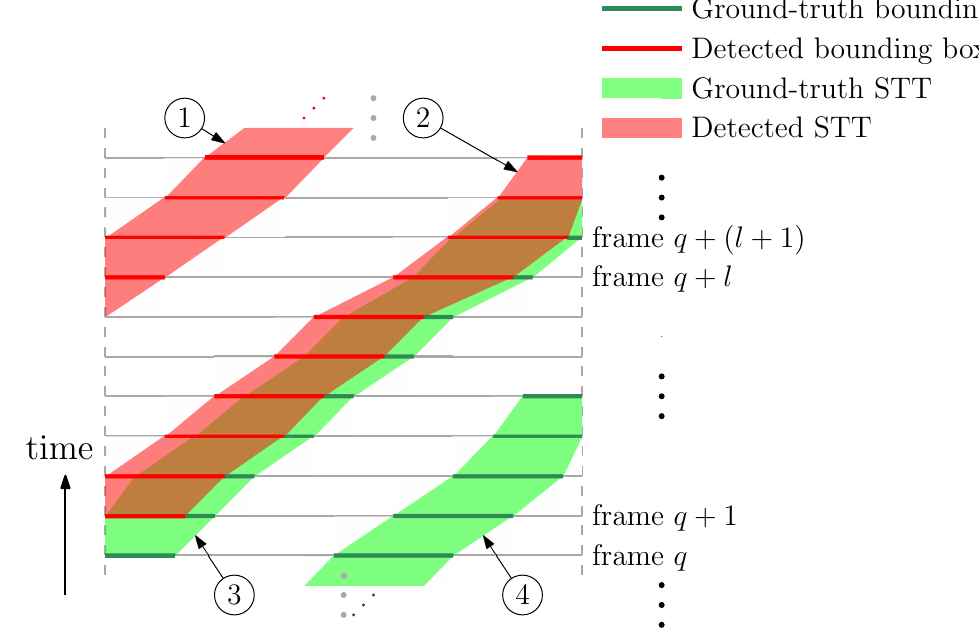
Figure 8. Illustration of STTs. The STT (1) constitutes a false positive (FP). The STT (2) may constitute true positive (TP) (depending on the STT-IOU) as the detection STT intersects the corresponding ground-truth STT (3). The STT (4) constitutes a false negative